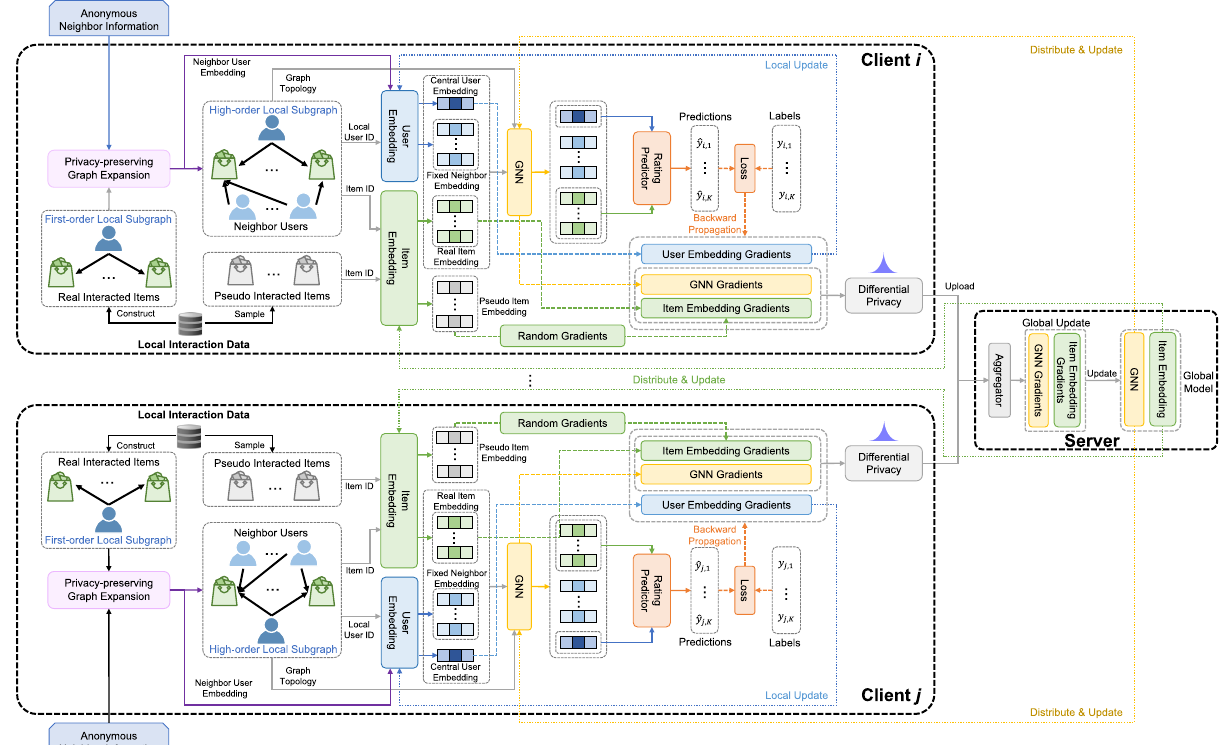
Fig. 7 The detailed framework of FedPerGNN. Each client locally stores the interaction data and constructs the fi rst-order local subgraph from it. This graph is expanded by the neighbor users. Several pseudo interacted items are also sampled from the local interaction data to hide real interacted items. The neighbor user embeddings are fi xed, and the central user embedding is locally updated. The item embedding and GNN gradients are perturbed before uploading to a server for aggregation, and the aggregated ones are delivered to clients for local